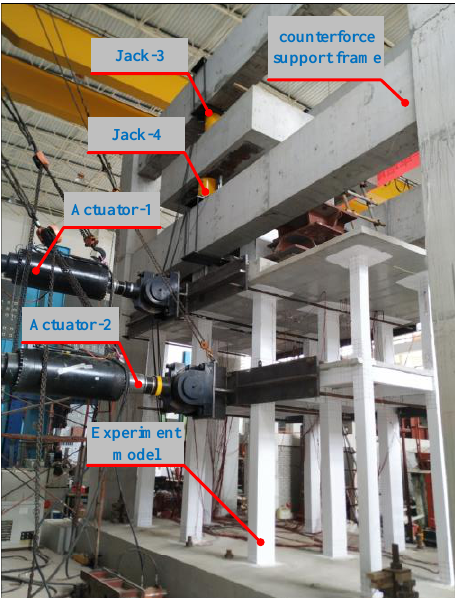
Figure 9. Loading diagram (the left image is positive loading and the right image is negative load- ing). Figure 9. Experimental Figure 10. Experimental model.